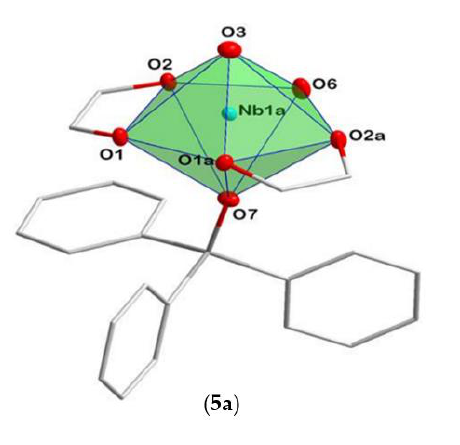
3.814 (2) Å is shorter than the average Nb-ca 2 − -Nb distance of 8.390 (2) Å .